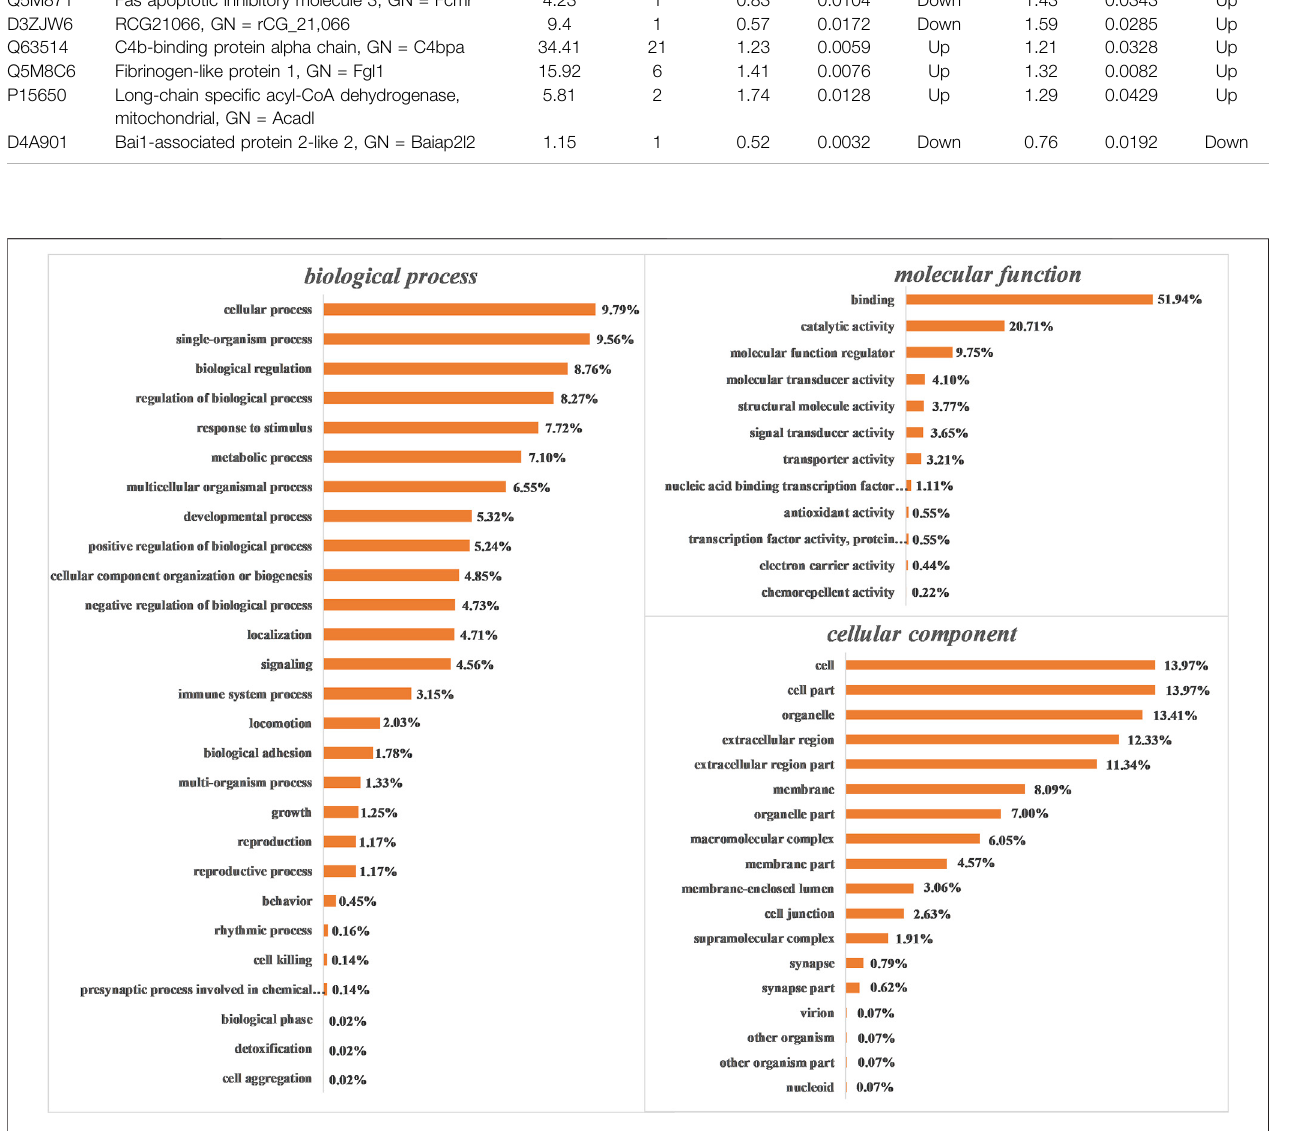
Frontiers in Pharmacology |